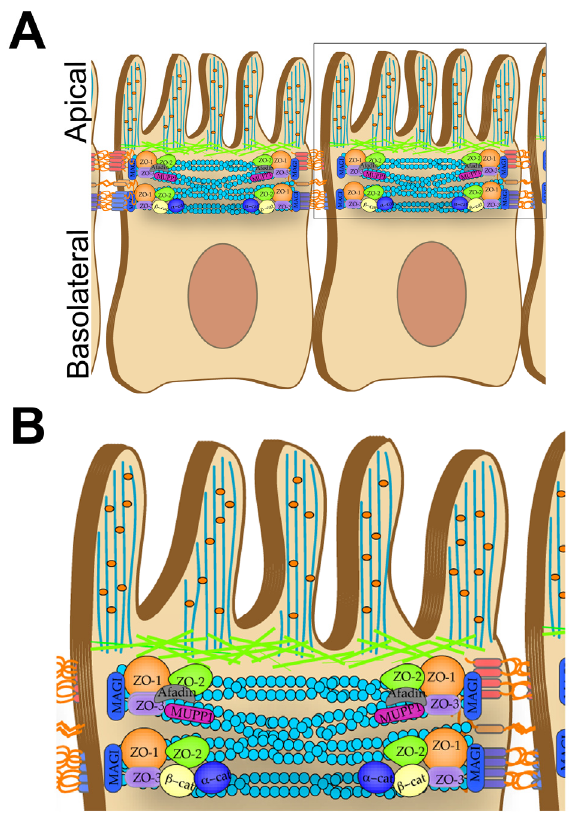
Figure 1. Model of Polarized Epithelial Cells. ( A ) Polarized intestinal epithelial cells (IECs) lining the gastrointestinal (GI) tract have distinct apical and basolateral surface domains. The apical domains are intimately associated with the actin cytoskeletal network. Microvilli localize to the apical surface and are anchored by interactions with actin-binding proteins ezrin, radixin, and moesin (ERM). ( B ) The highlighted area of the apical domain demonstrates the close interactions between actin and junctional complex proteins [ZO-1, ZO-2, ZO-3, Afadin, multi-PDZ domain protein 1 (MUPP1), MAGI, α - and β